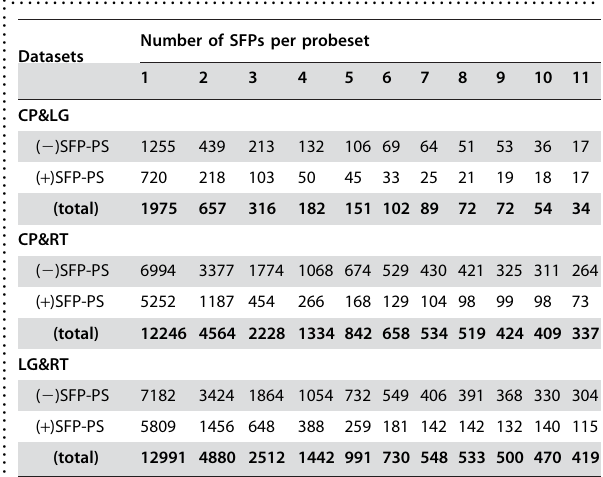
The probesets (PS) and SFPs data have been taken from estimated FDR (delta) of 11.9% (delta=2) in CP&LG, 10% (delta=2) in CP&RT and 10% (delta=1.6) in LG&RT respectively. The sign ( + / 2 ) indicates direction of polymorphism as explained in Figure 3 legend. CP=Cypress, LG=LaGrue and RT=RT0034.